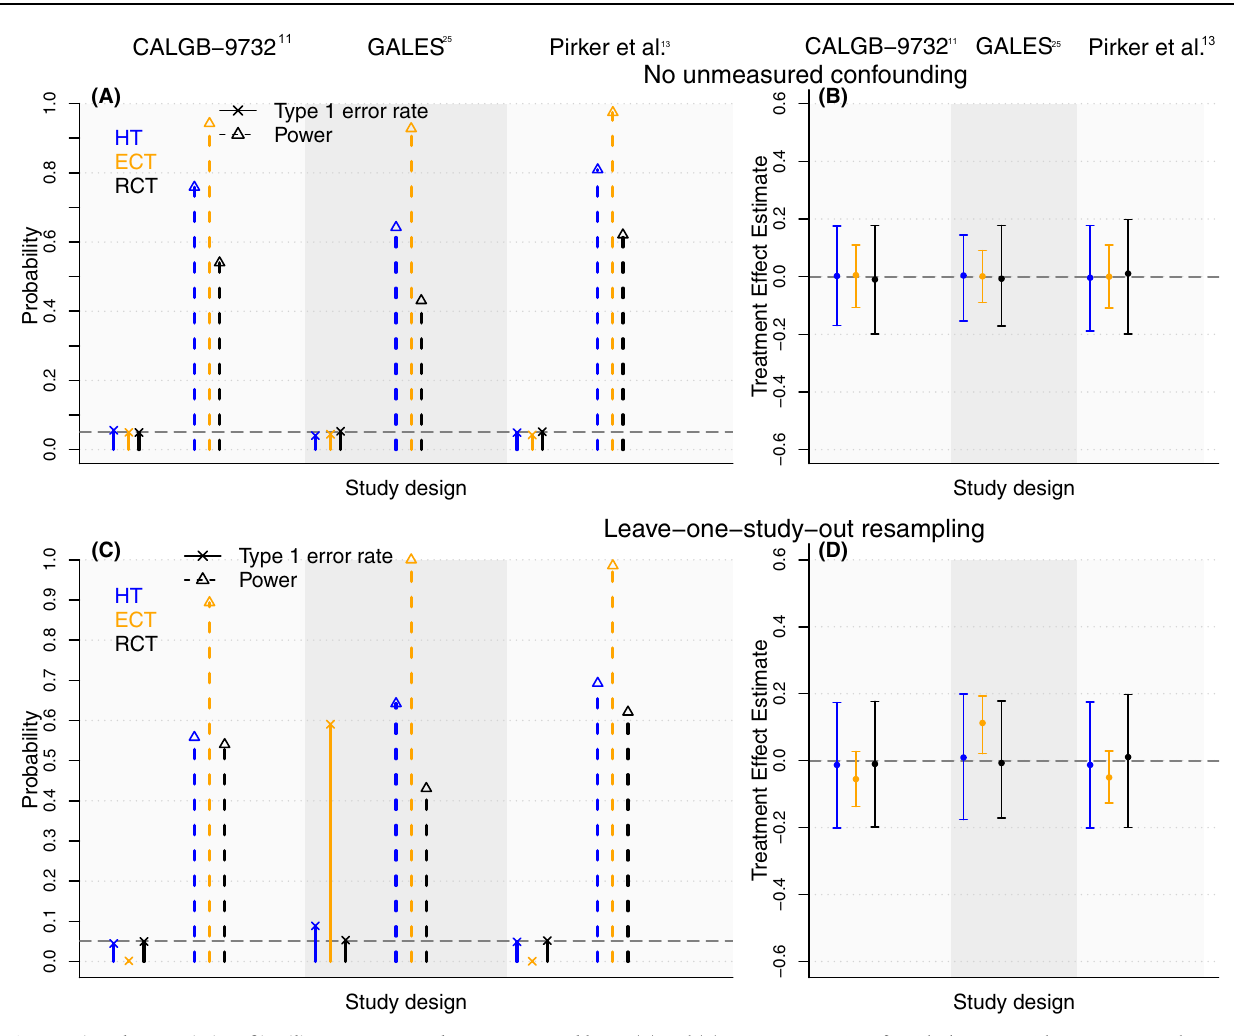
Fig. 2 | Operating characteristics of in silico HTs, ECTs and RCTs generated by resampling the control arms of the ES-SCLC studies. The top row shows type I errorrates(panel A ,solidverticallineswithacross),power(Panel A ,dottedvertical lineswithanarrow),andthevariability/biasofthetreatmenteffectestimates(panel B ). In panel ( B ), the dots indicate the average treatment effect estimates across in silico trials ( n = 75) and the vertical bars indicate the 5% and 95% quantiles. Panels